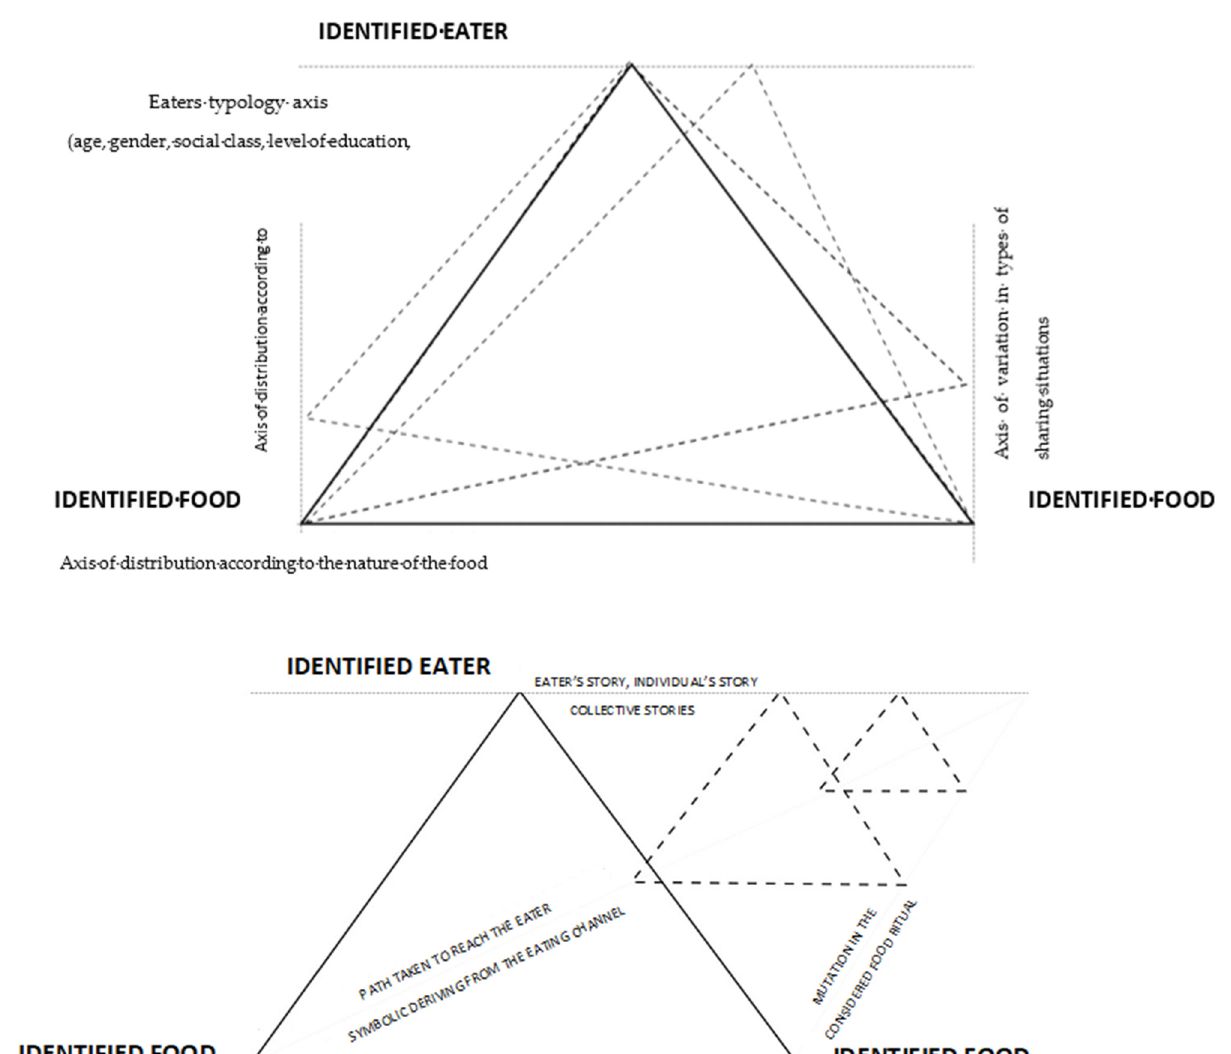
Figure 1. Different Triangular model combining, diachronically and synchronically, the eater, the lipidic product, and the meeting point between the eater and the food.